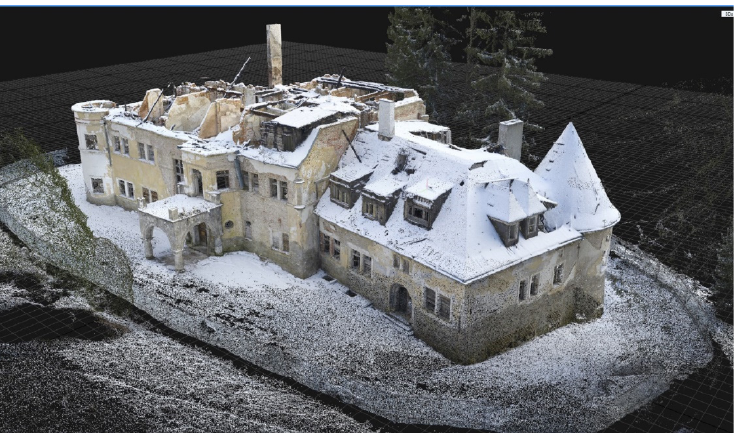
Figure 9. Point cloud of the Kunerad manor.